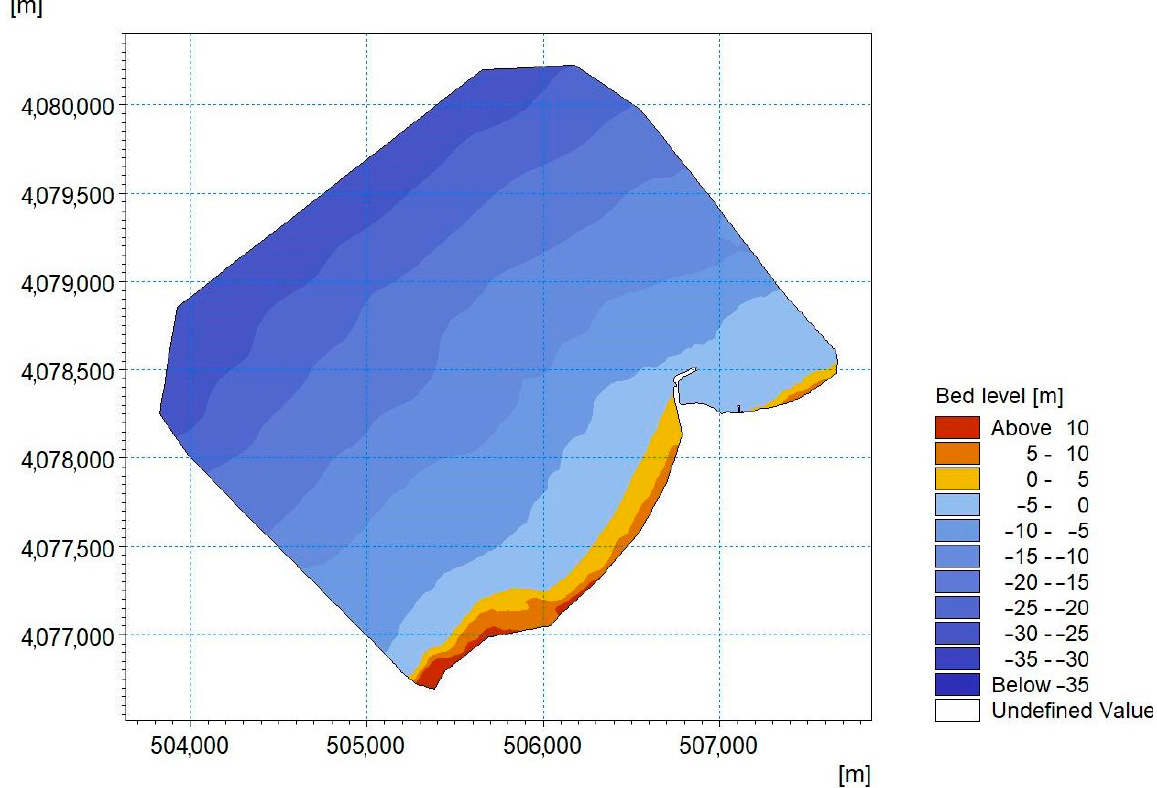
Figure 3. The bathymetry and topography map of the computational domain.